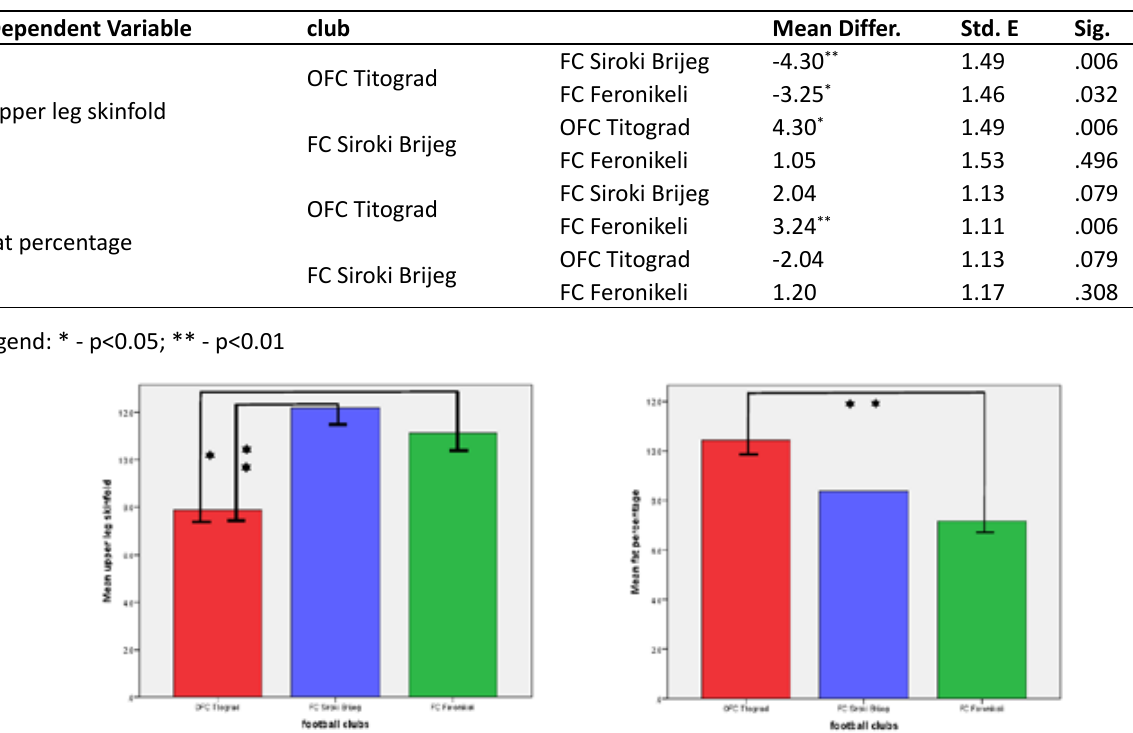
Figure 1. Statistically significant differences between young football players of football clubs in two variables - upper leg skinfold and fat percentage (*p<.05; **